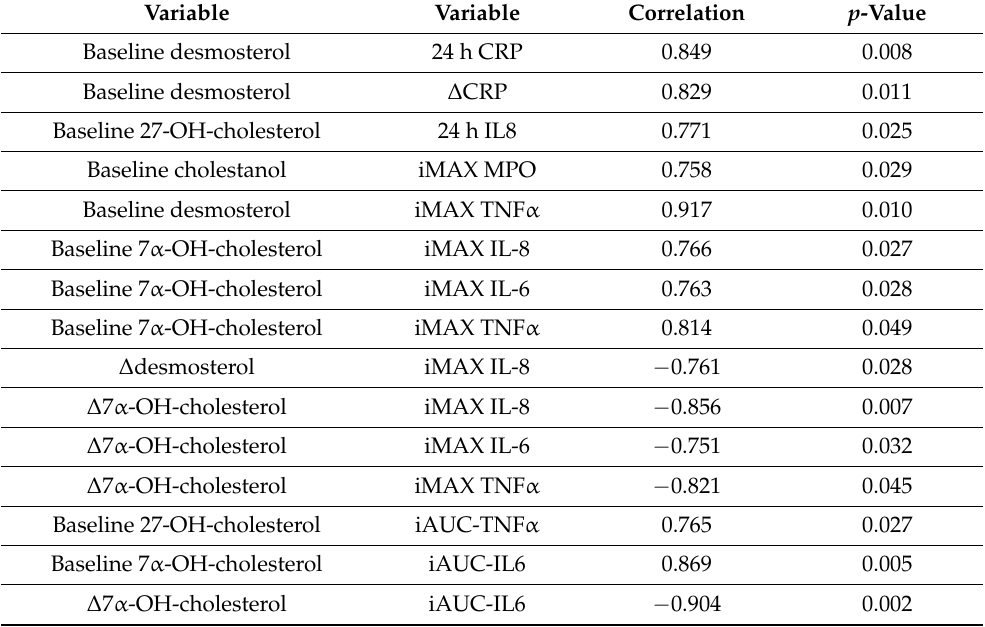
Table 2. Correlations between plasma non-cholesterol sterols, oxysterols, and inflammation responses ‡